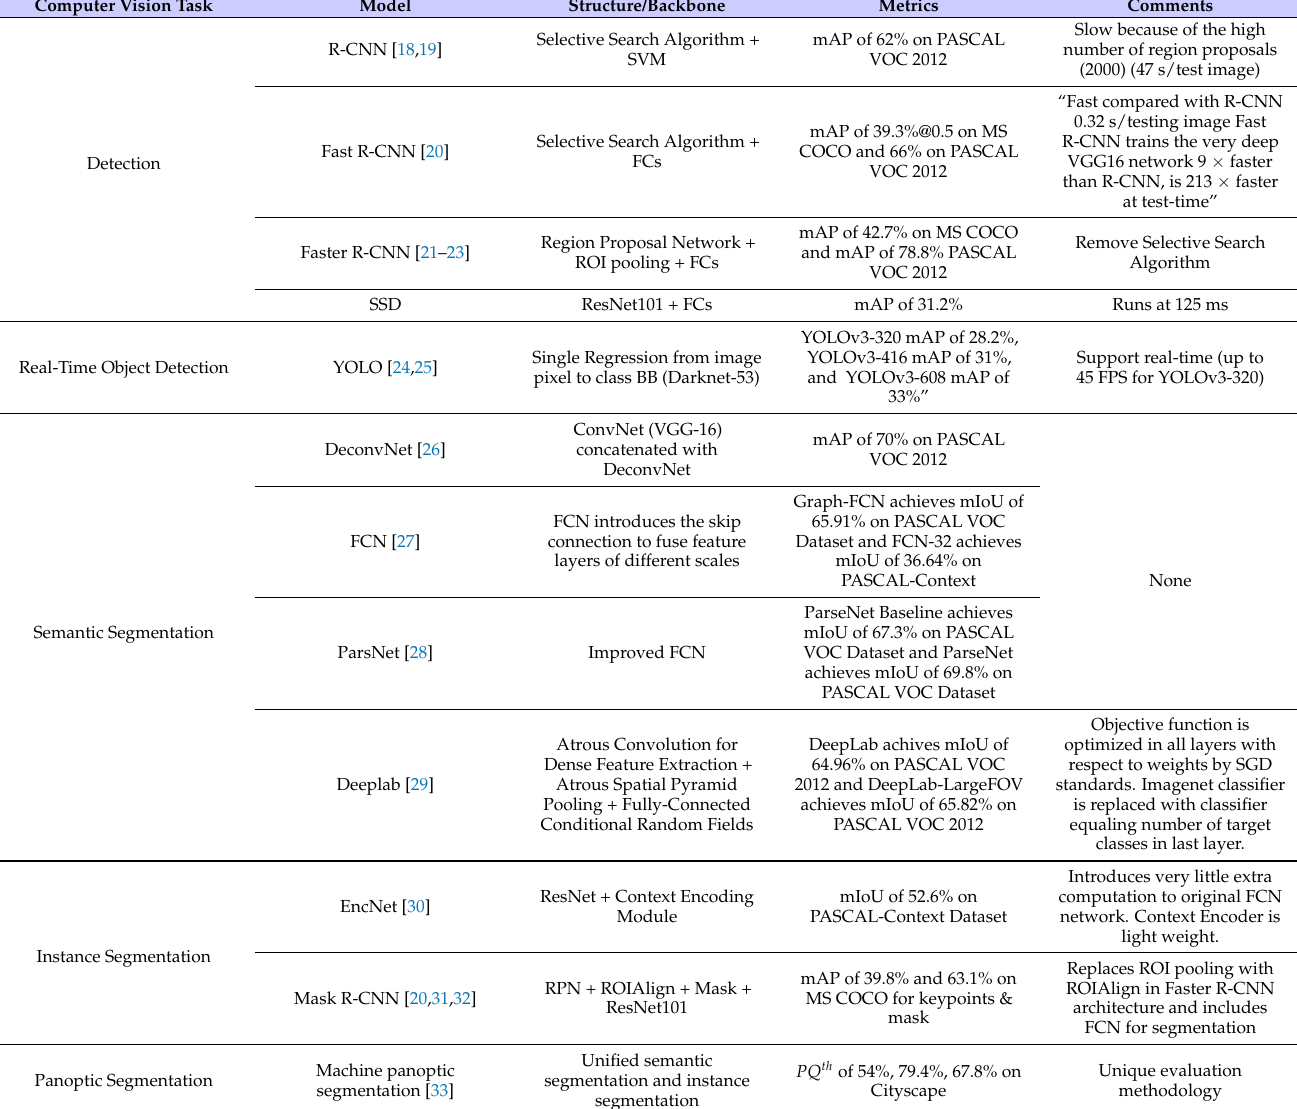
Table 1. State-of-the-art computer vision